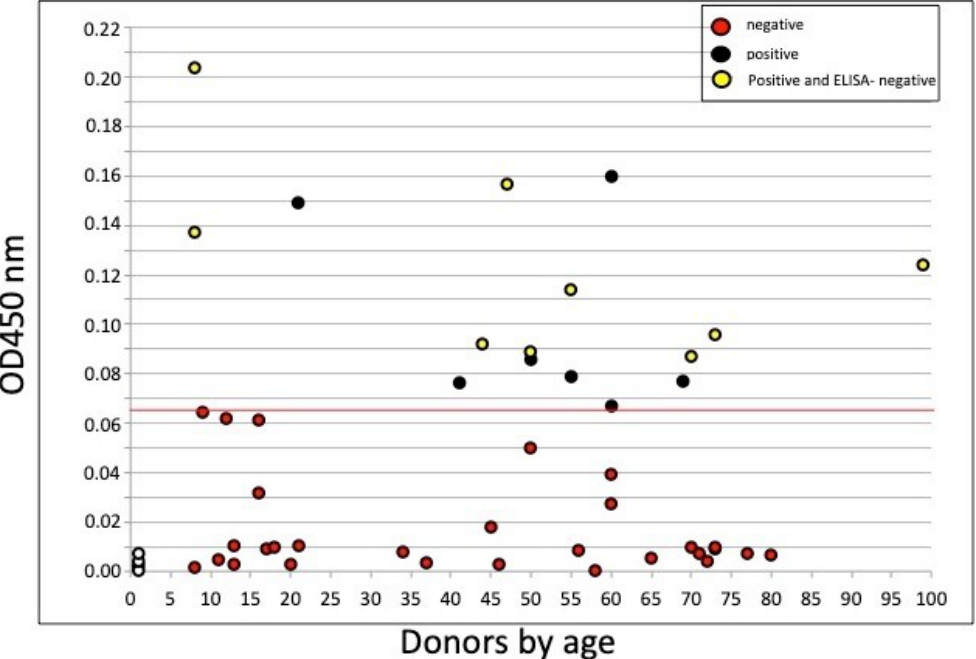
Figure 1. C ell-ELISA of in vitro-secreted IgG in peripheral blood mononuclear cells (PBMCs) from